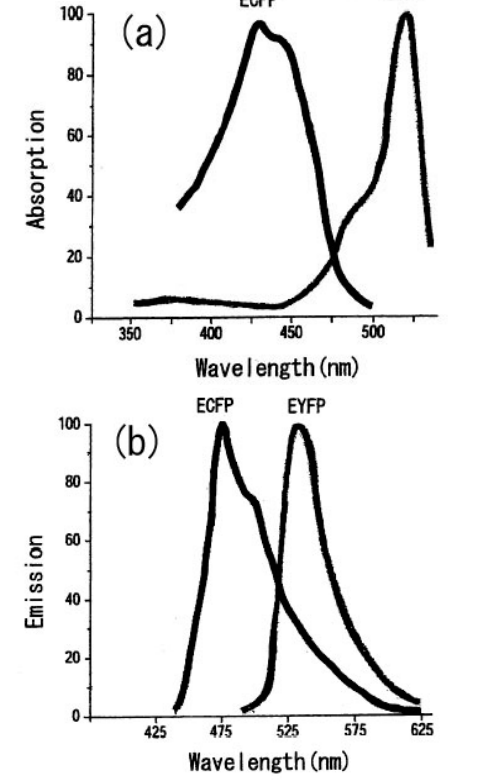
Figure 8. (a) Absorption and (b) emission spectra of various GFP mutants.